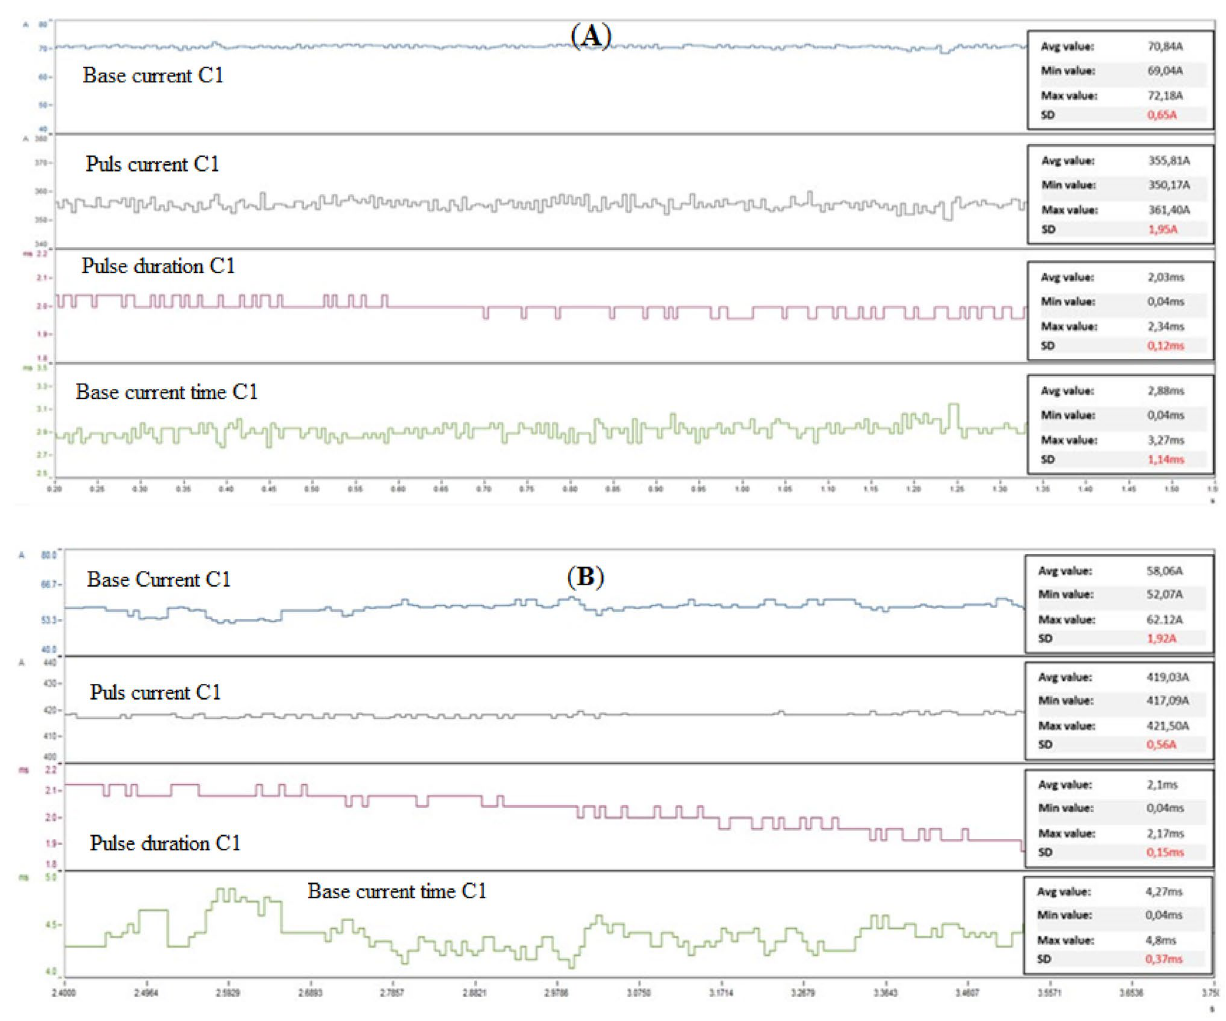
Fig. 15 Image of a time duration of 1.35 s for: A- Linear waveform and; B- Exponential